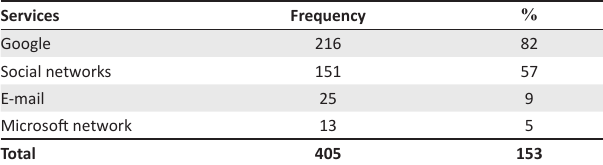
TABLE 5: Internet sources or services that learners use the